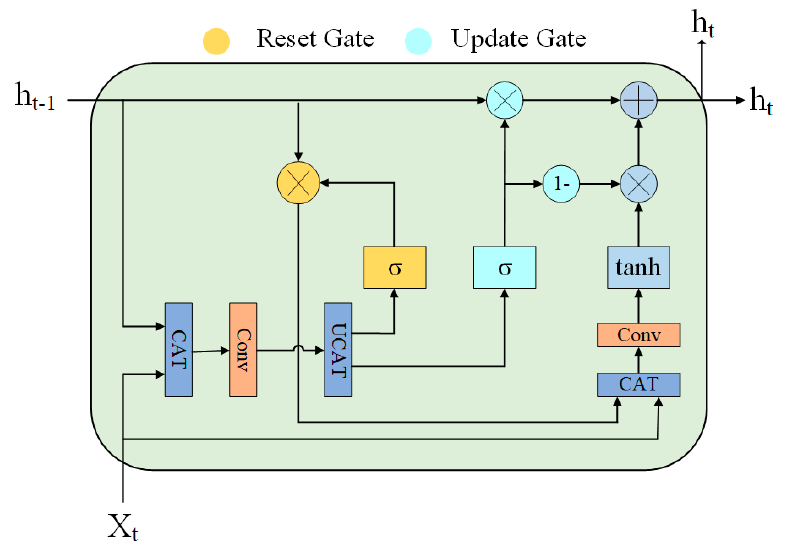
Figure 8. Internal structure of the ConvGRU cell.